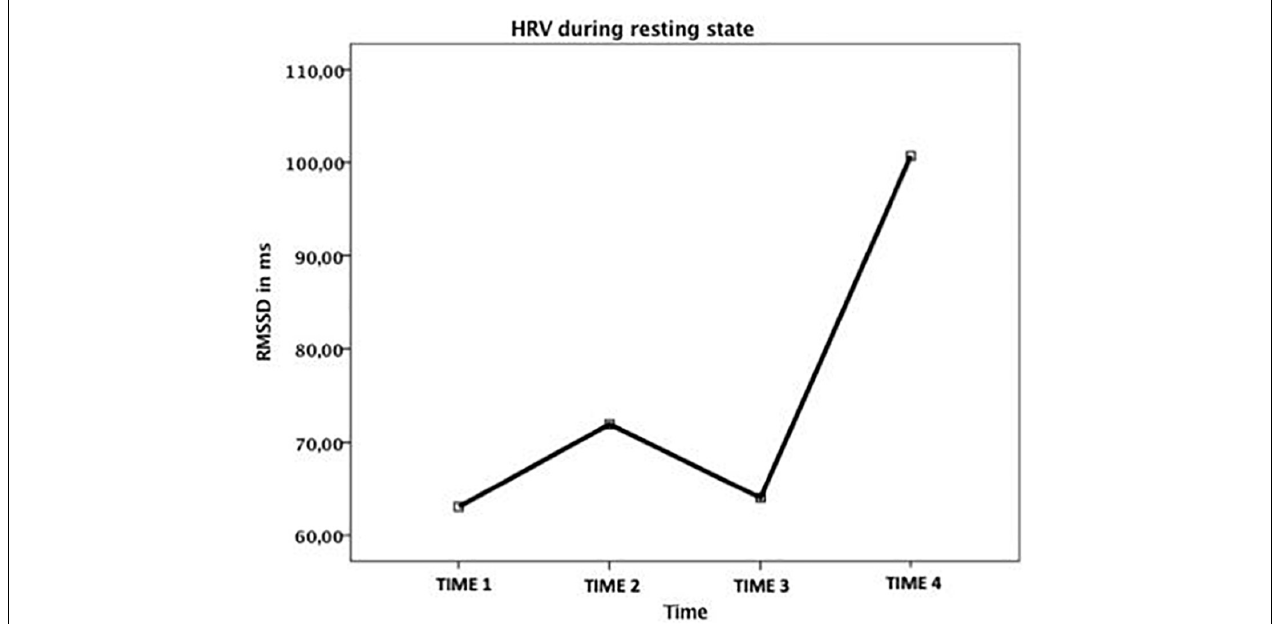
FIGURE 5 | HRV (RMSSD in ms) during resting state at four assessment times.